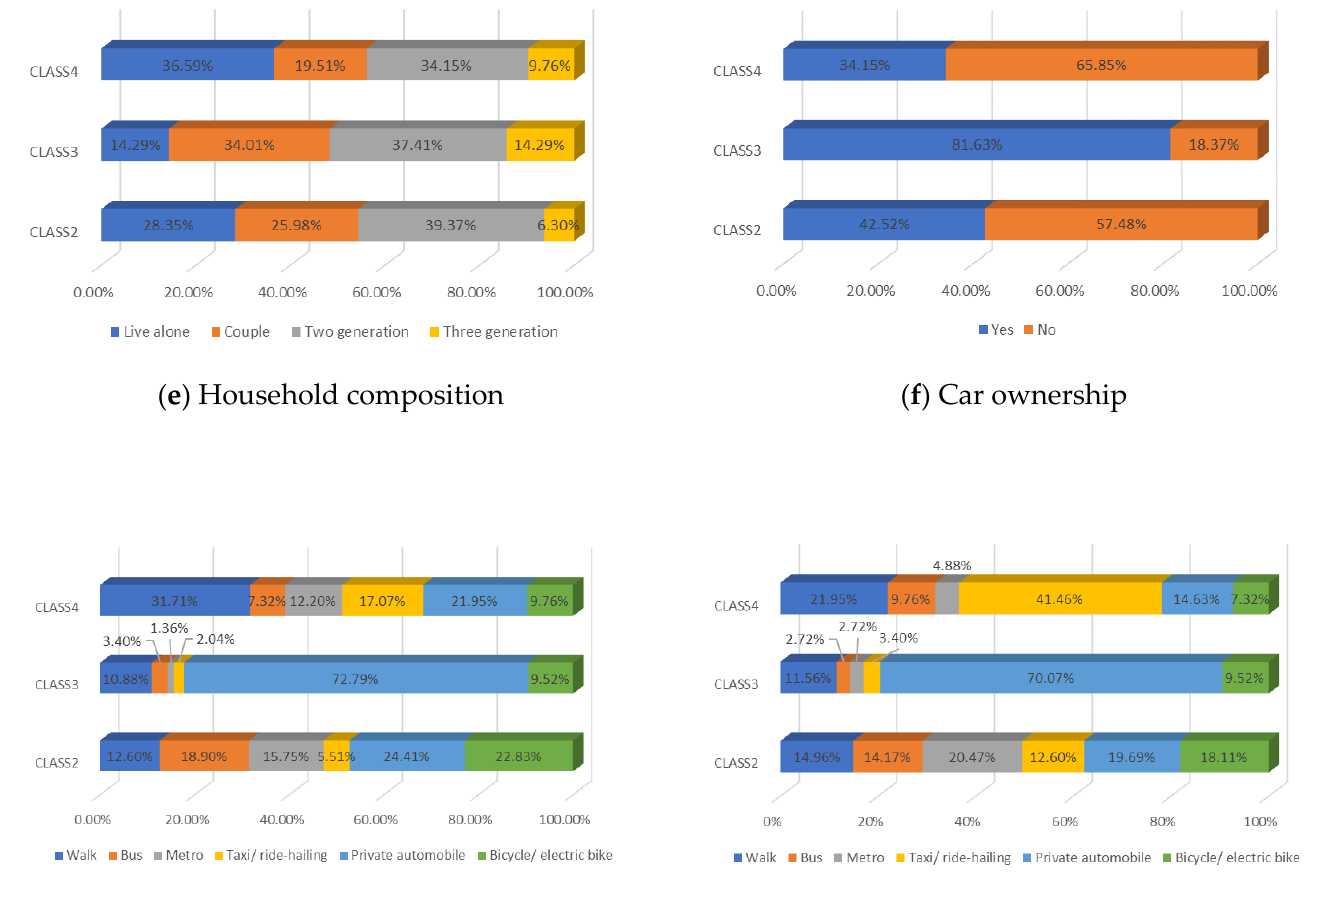
Figure 5. Characteristics of each